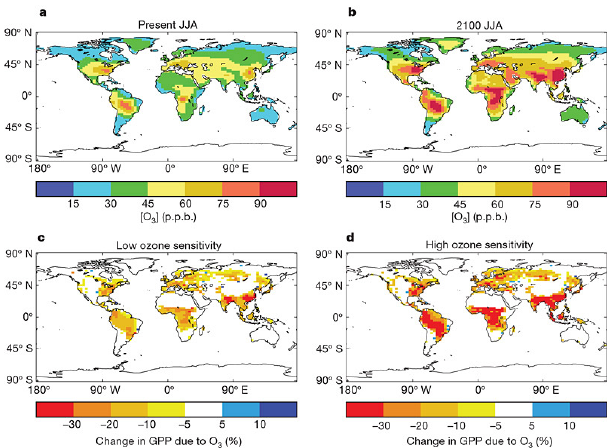
Figure 29. (a, b) Modelled diurnal (24h) mean surface [O 3 ] in pbb averaged over June, July and August (JJA) for the present day (a) and the year 2100 under the highly polluted SRES A2 emissions scenario (b) . (c, d) Simulated percentage change in gross primary productivity (GPP) between 1901 and 2100 due to O 3 effects at fixed pre-industrial atmospheric [CO 2 ] for “low” (c) and “high” (d) ozone plant sensitivity (Sitch et al.,